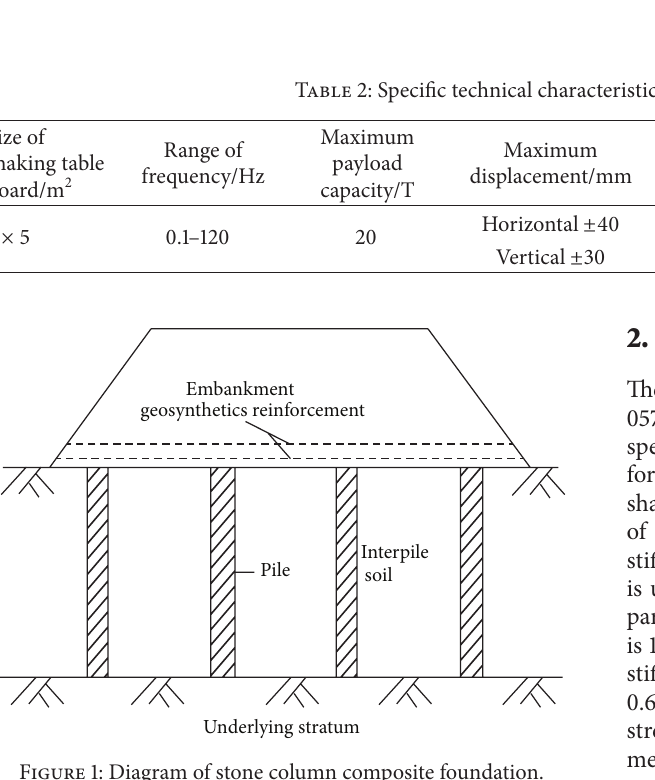
Figure 1: Diagram of stone column composite foundation.